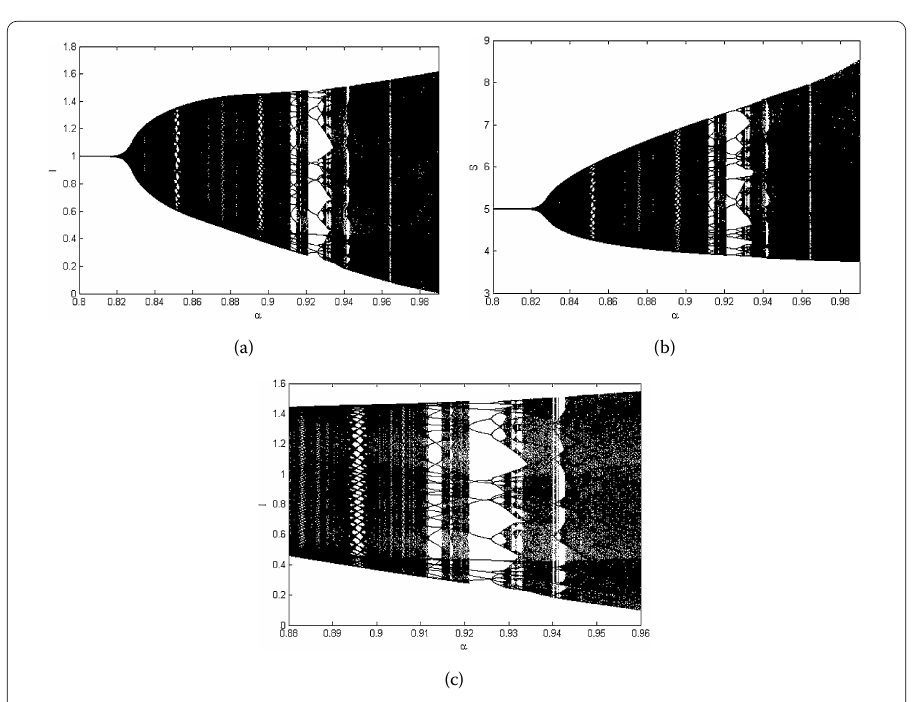
Figure 4 N-S bifurcation diagram of model (3.7) for α ∈ [0.8,0.99] with local amplification to (a)